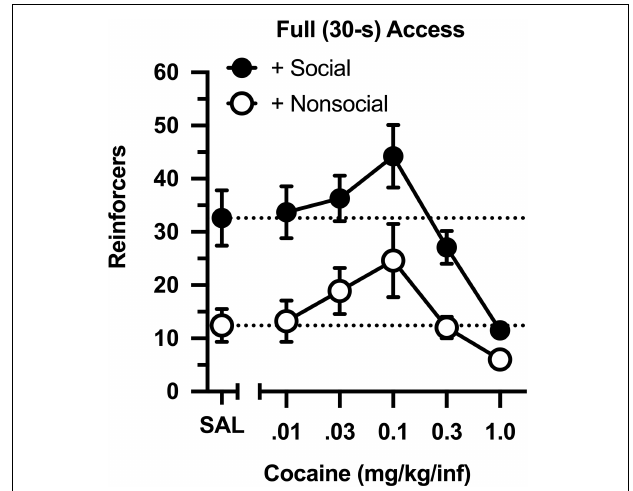
FIGURE 2 | Number of reinforcers obtained during daily, 60-min test sessions under full (30-s) access conditions. Data reflect the mean (SEM) number of infusions from rats assigned to the social (“+ Social,” filled symbols; n = 12) and non-social (“+ Non-social,” open symbols; n = 9) groups. Responding was maintained by various doses of cocaine (0.01–1.0 mg/kg/inf) and either a social (sex- and age-matched partner) or non-social (black-and-white athletic sock) stimulus. Dashed lines originating at the X-intercept reflect the average number of infusions during a saline substitution test (SAL).